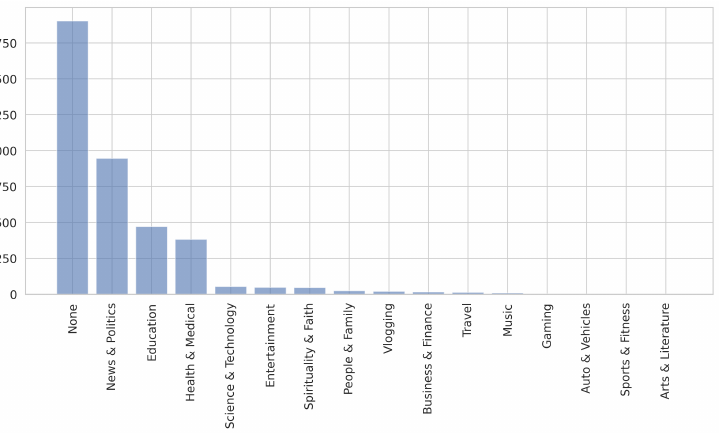
Figure 6. Categorization of the BitChute